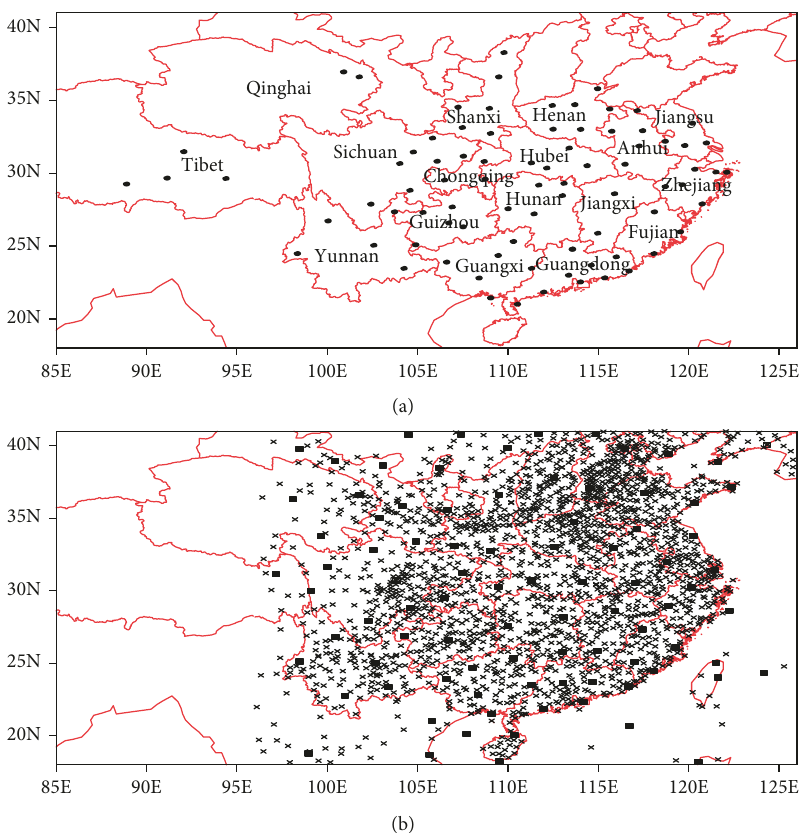
Figure 1: (a) Locations of Doppler radar sites in China (black solid circles), and (b) radiosonde (black hollow squares) and surface meteorological sites ( ×